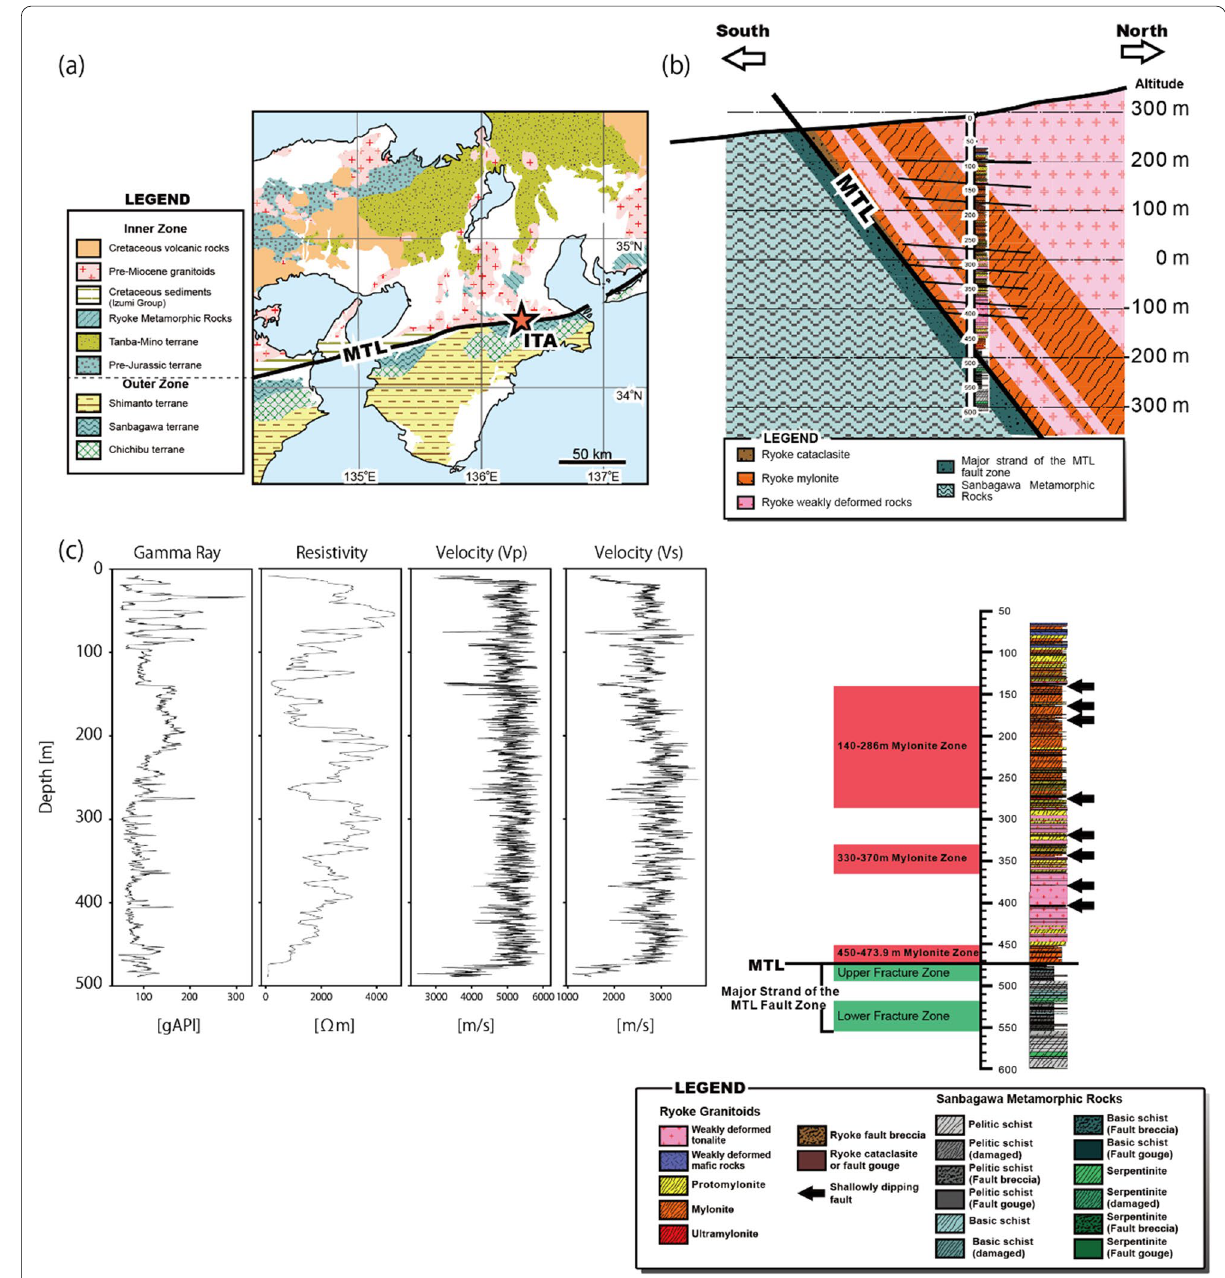
Fig. 5 Geological map and data summary at Site ITA. a Regional map of the Kii Peninsula showing the location of Site ITA based on Shigematsu et al. (2012). b Interpreted cross‑section image around Site ITA after Shigematsu et al. (2012). c Logging data and core description previously reported by Shigematsu et al.